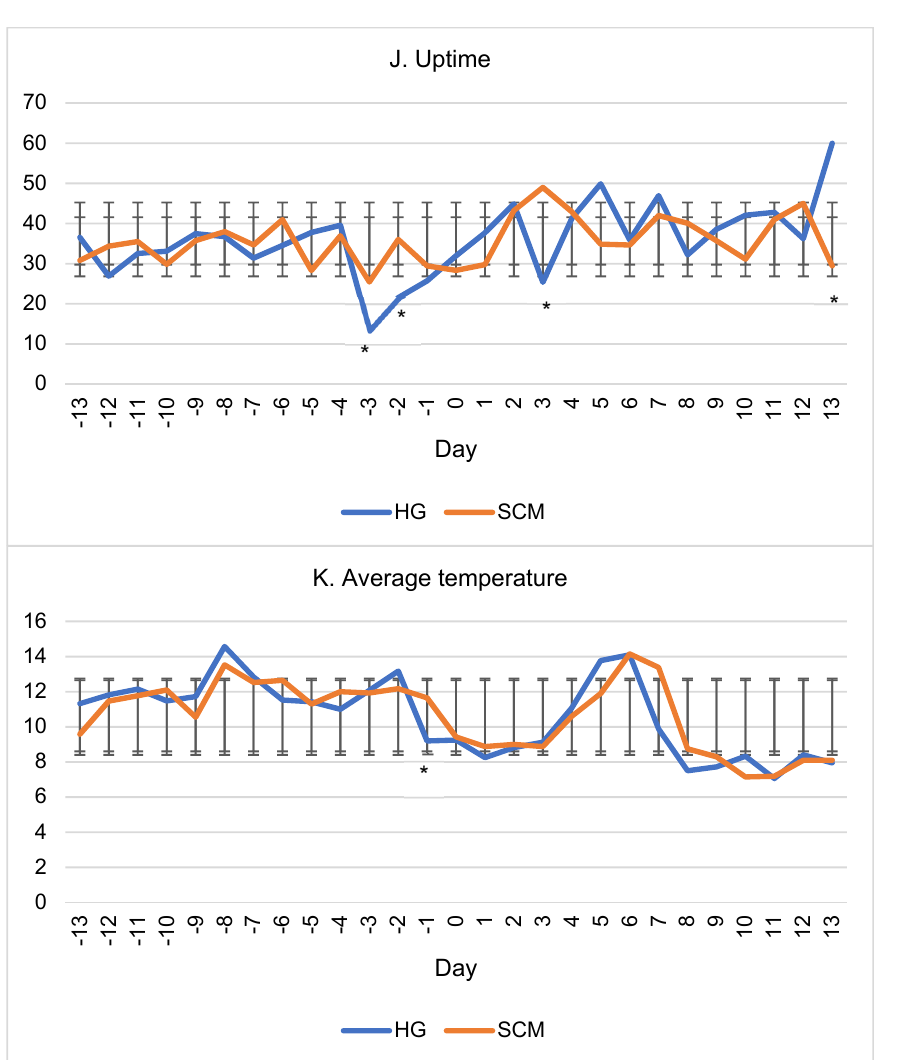
Figure 2. Indicators of cow groups by days of experiment. ( A ). Rumination time; ( B ). Eating time; ( C ). Drinking time; ( D ). Rumination chews; ( E ). Eating chews; ( F ). Drinking gulps; ( G ). Bolus; ( H ). Activity; ( I ). Downtime; ( J ). Uptime; ( K ). Average temperature; HG: clinically healthy group; SCM: subclinical mastitis group (SCM). Error bars indicate standard deviation. The difference between the mean values of the groups is statistically significant at * = p < 0.05. The correlation coefficients of the HG group are presented above the diagonal. The group of SCM cows is shown below the diagonal.